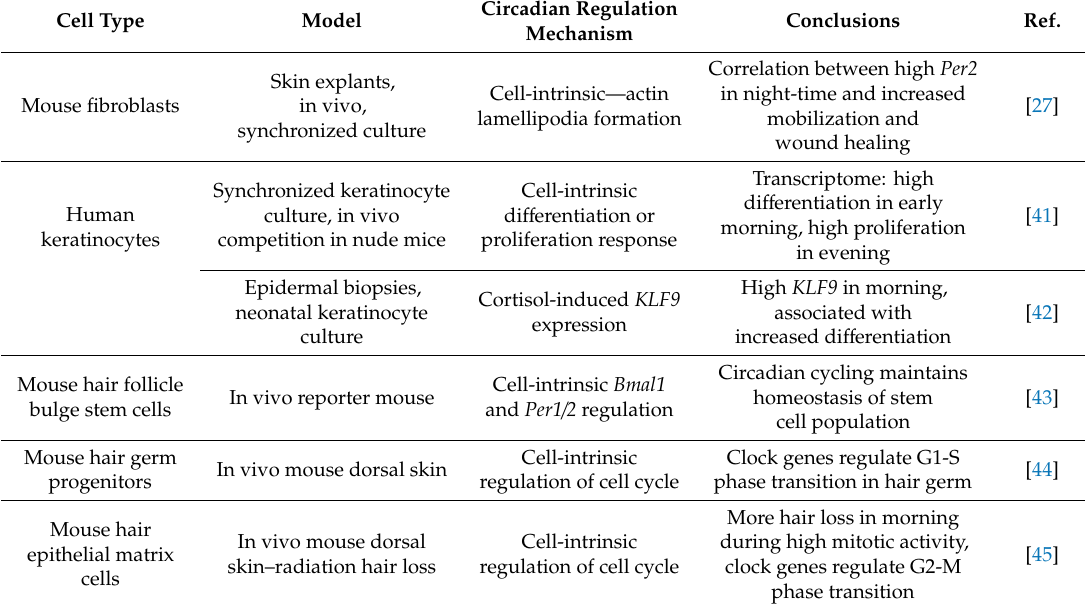
Table 1. Circadian regulation of skin